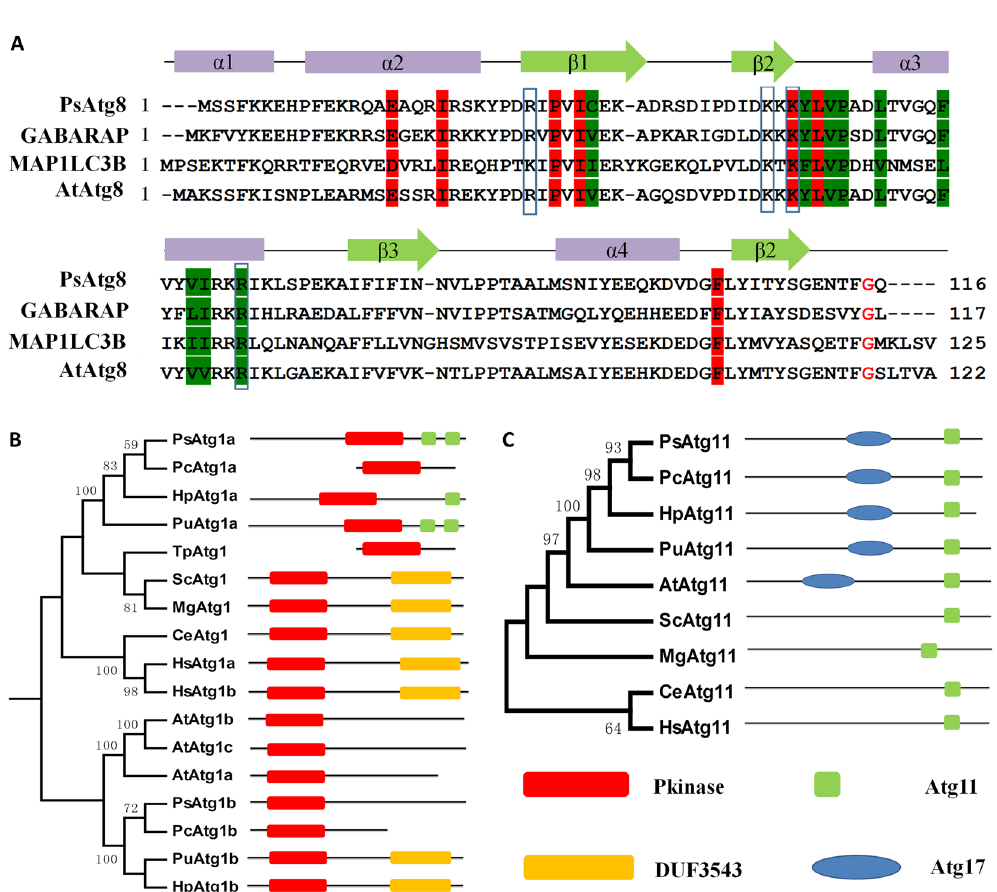
Figure 3. Phylogenetic relationship and domain structures of selected ATGs. ( A ) Sequence features of Atg8 proteins. Atg8 proteins from H . sapiens (GABARAP and MAP1LC3B), A . thaliana (AtAtg8) and P . sojae (PsAtg8) are shown. Atg8 proteins of different species are highly conserved across their entire length, and very similar to each other in most positions. ( B ) and ( C ) Phylogenetic relationship and domain structures of Atg1 and Atg11. The phylogenetic trees of Atg1 ( B ) and Atg11 ( C ) proteins identified from P . sojae ( Ps ), P . capsici ( Pc ), H . parasitica ( Hp ), Py . ultimum ( Pu ), T . pseudonana ( Tp ), A . thaliana ( At ), C . elegans ( Ce ), H . sapiens ( Hs ), S . cerevisiae ( Sc ), and M. grisea ( Mg ). Pkinase: kinase domain. Atg11: Atg11 domain. DUF3543: DUF3543 domain. Atg17: Atg17